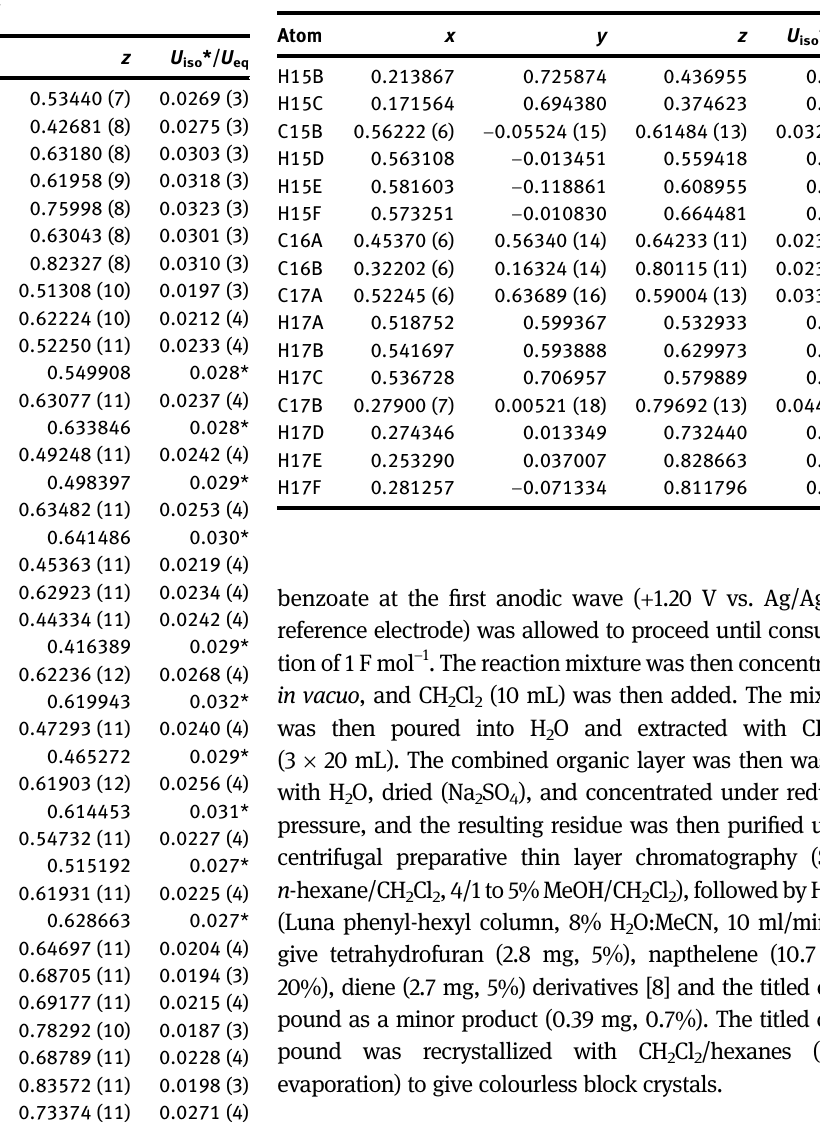
Table  : Fractional atomic coordinates and isotropic or equivalent isotropic displacement parameters (Å 